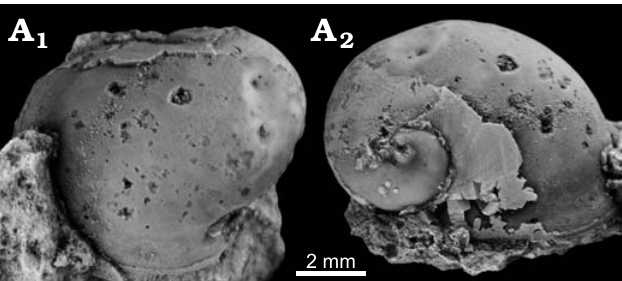
Fig. 13. Neritimorpha indet. (PRI 80015) from the early Cenozoic Lomitos cherts seep deposits near Negritos, Talara Basin, northern